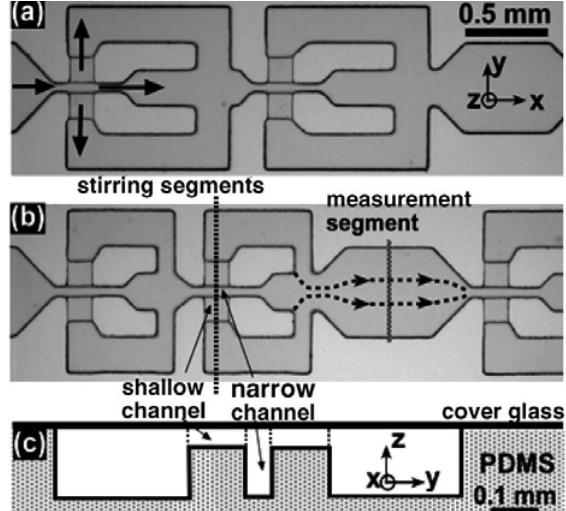
Figure 14. (a, b) Sketch of the two kinds of channel mixer with a single-layer structure and (c) the cross-sectional view of the plane cut by a dotted line in (b) (from Simonnet and Groisman